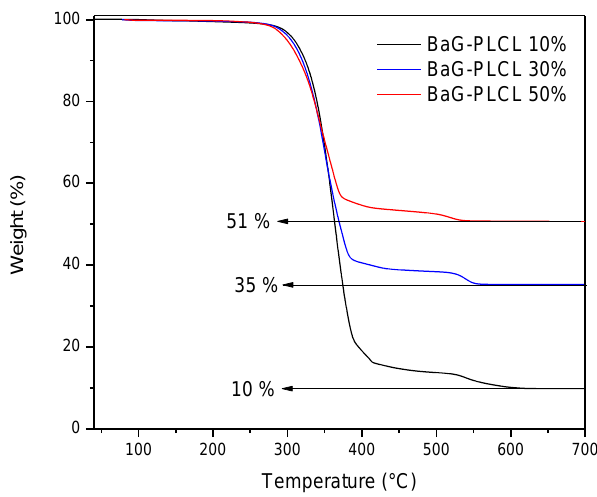
Figure 8. TGA thermogram of the composites under investigation.